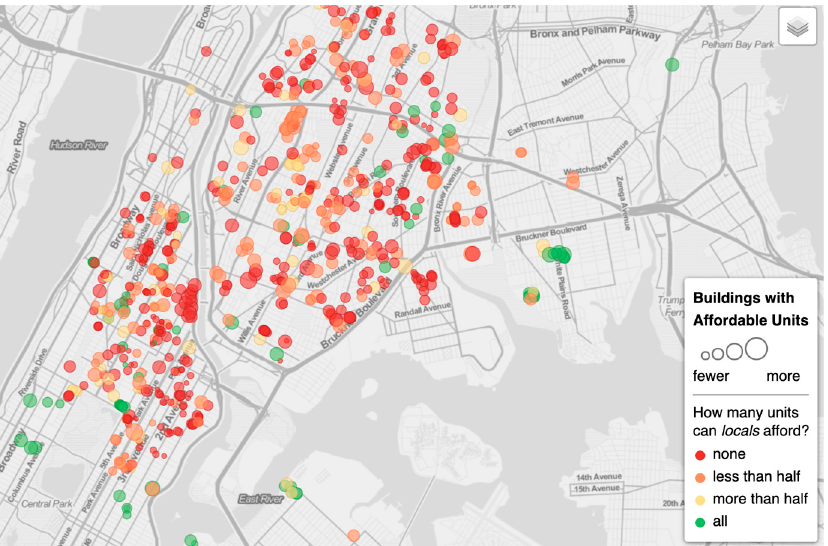
Figure 4. Buildings with a ff ordable units for a typical median household, for the South Bronx and Northern Manhattan, including Central Harlem (2018). Source: Sam Raby’s data analysis for Curbed, Vox Media. Data sources: American Community Survey, New York Open Data, Housing and Urban Development O ffi ce of Policy Development and Research. Accessed September 30, 2019 at https: // voxmedia.github.io / curbed-maps / HNY